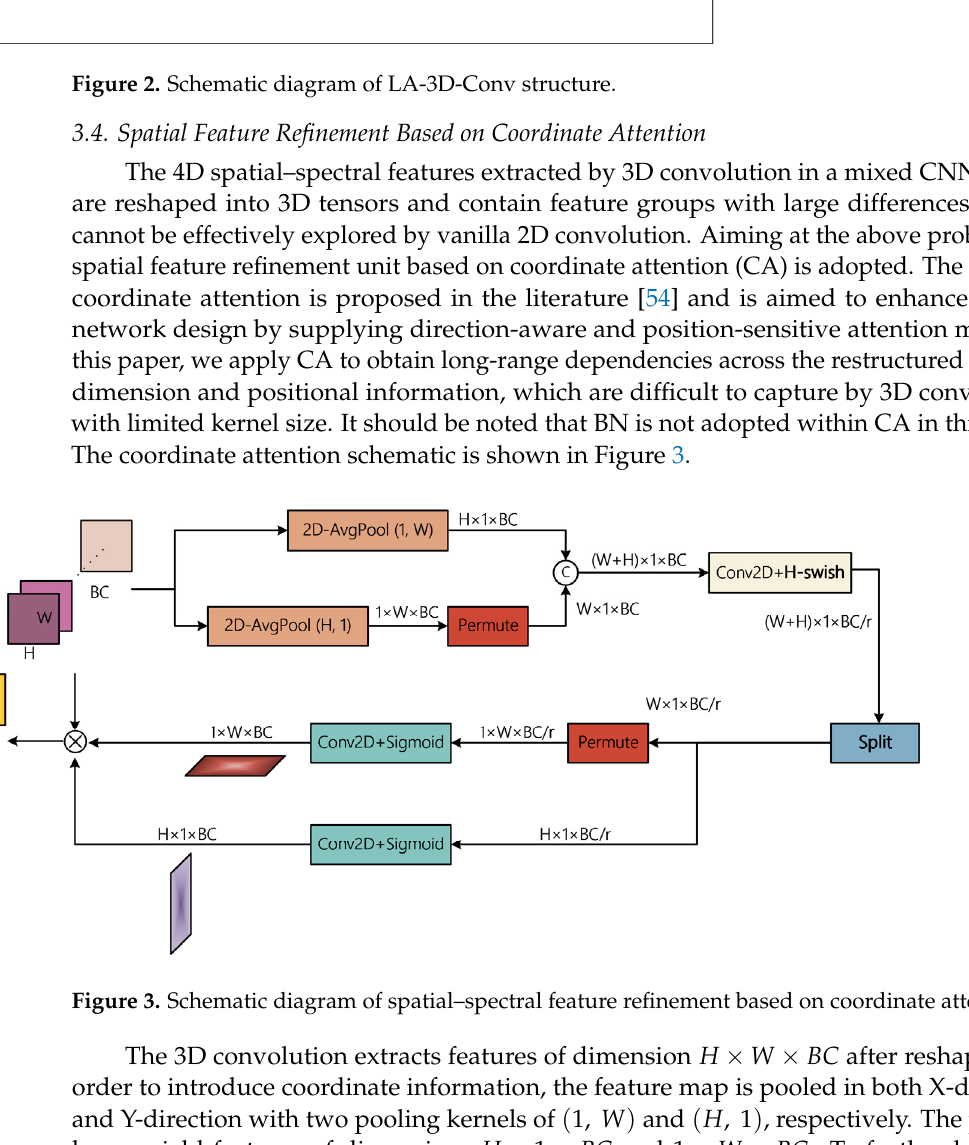
Figure 3. Schematic diagram of spatial–spectral feature refinement based on coordinate attention.